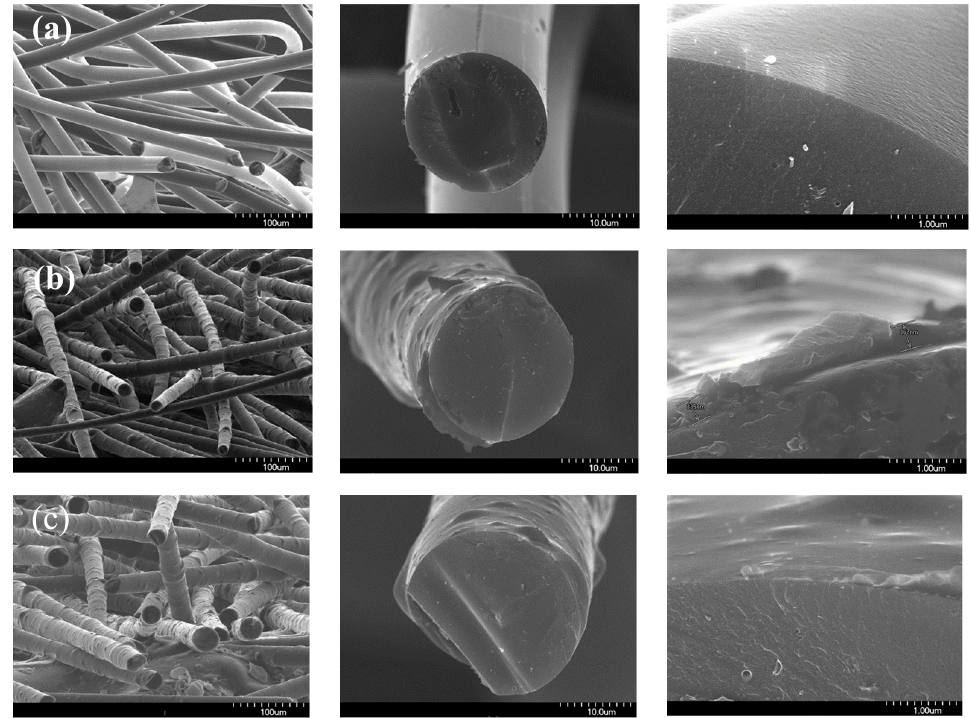
Figure 3. SEM images of PFO # -based carbon fibers; ( a ) PFO # , ( b ) PFO # /0.1 graphene, and ( c ) PFO # /1.0 graphene .